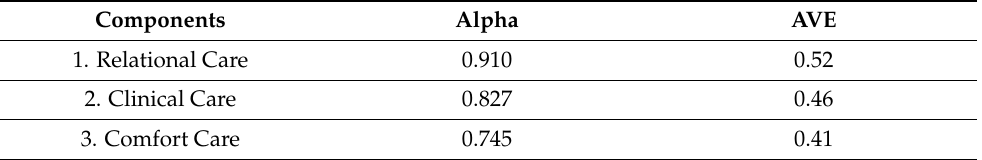
Table 2. Analysis of the construct validity of EIEP-22-PT in the hospital care in